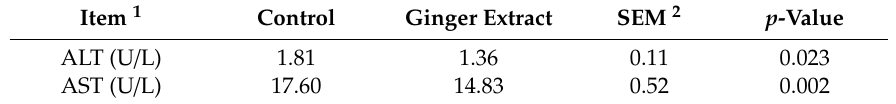
Table 5. E ff ects of ginger extract on serum transaminase activities of laying hens.